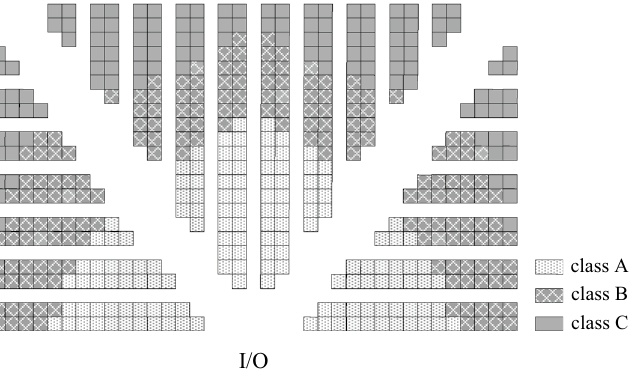
Figure 1. Fishbone layout warehouse under the class-based storage strategy (created with Microsoft Visio Professional 2019, 16.0.14827.20216, https:// www. micro soft. com/ en- gb/ micro soft- 365/ visio/ flowc hart- softw